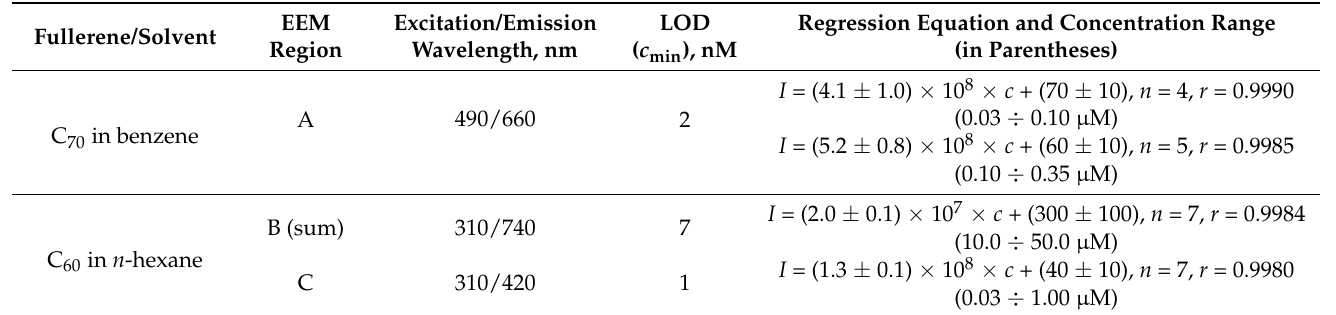
Table 1. Performance parameters of EEM fluorescence quantification of fullerenes ( p = 0.95); experi- mental parameters: emission/excitation slits, 20/20 nm, detector voltage, 1000 V.